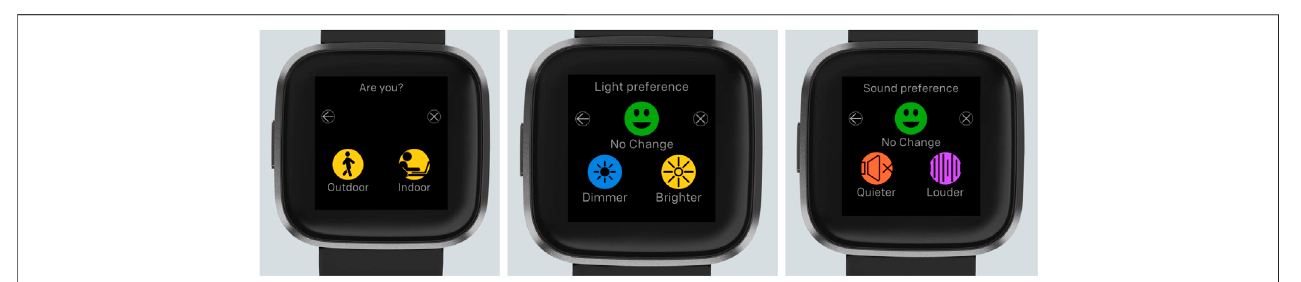
FIGURE 2 | An example of questions used in the data accessibility